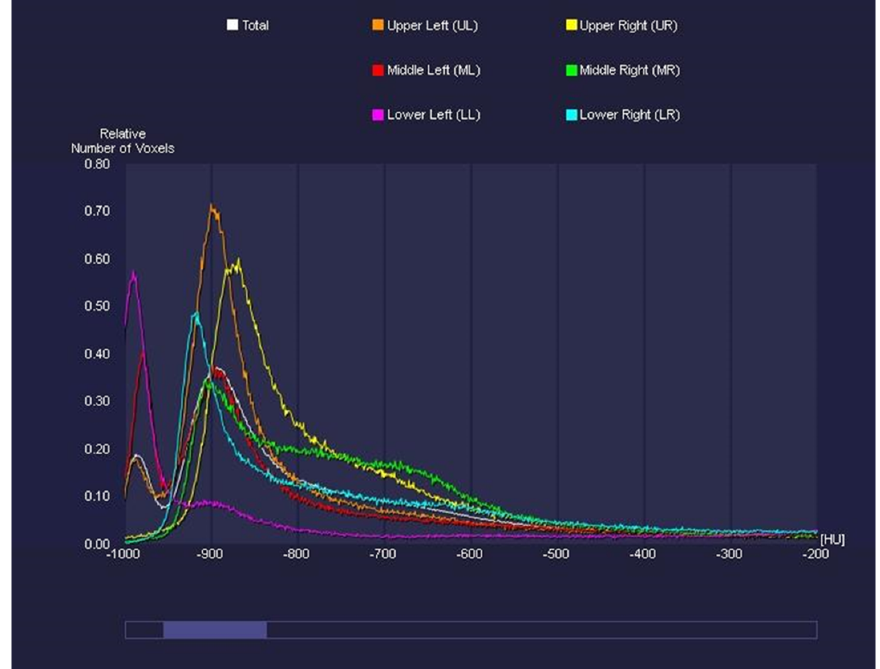
Figure 6. CT Pulmo 3D: thresholds and volumes. This figure shows the HU thresholds and relative volumes per lobe.